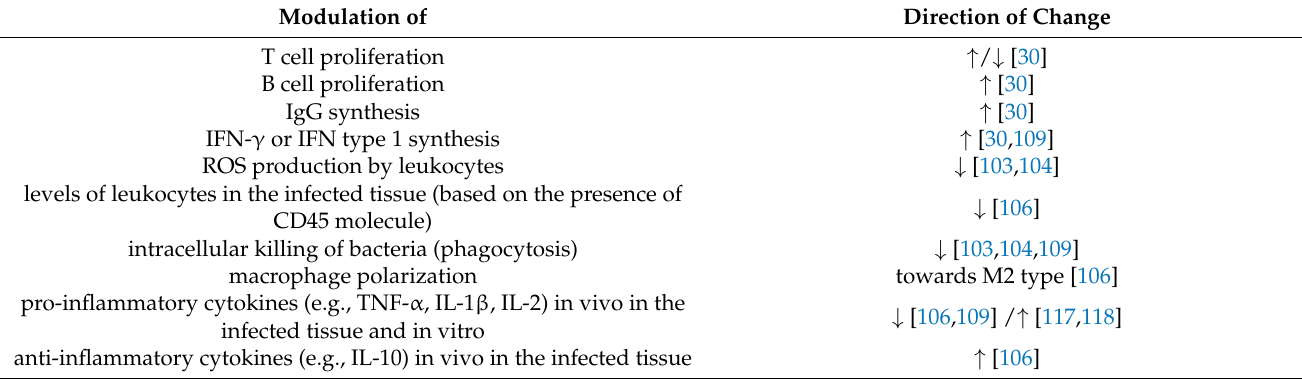
Table 1. The influence of the prophage present in the bacterial genome on the immune system. Modulation of Direction of